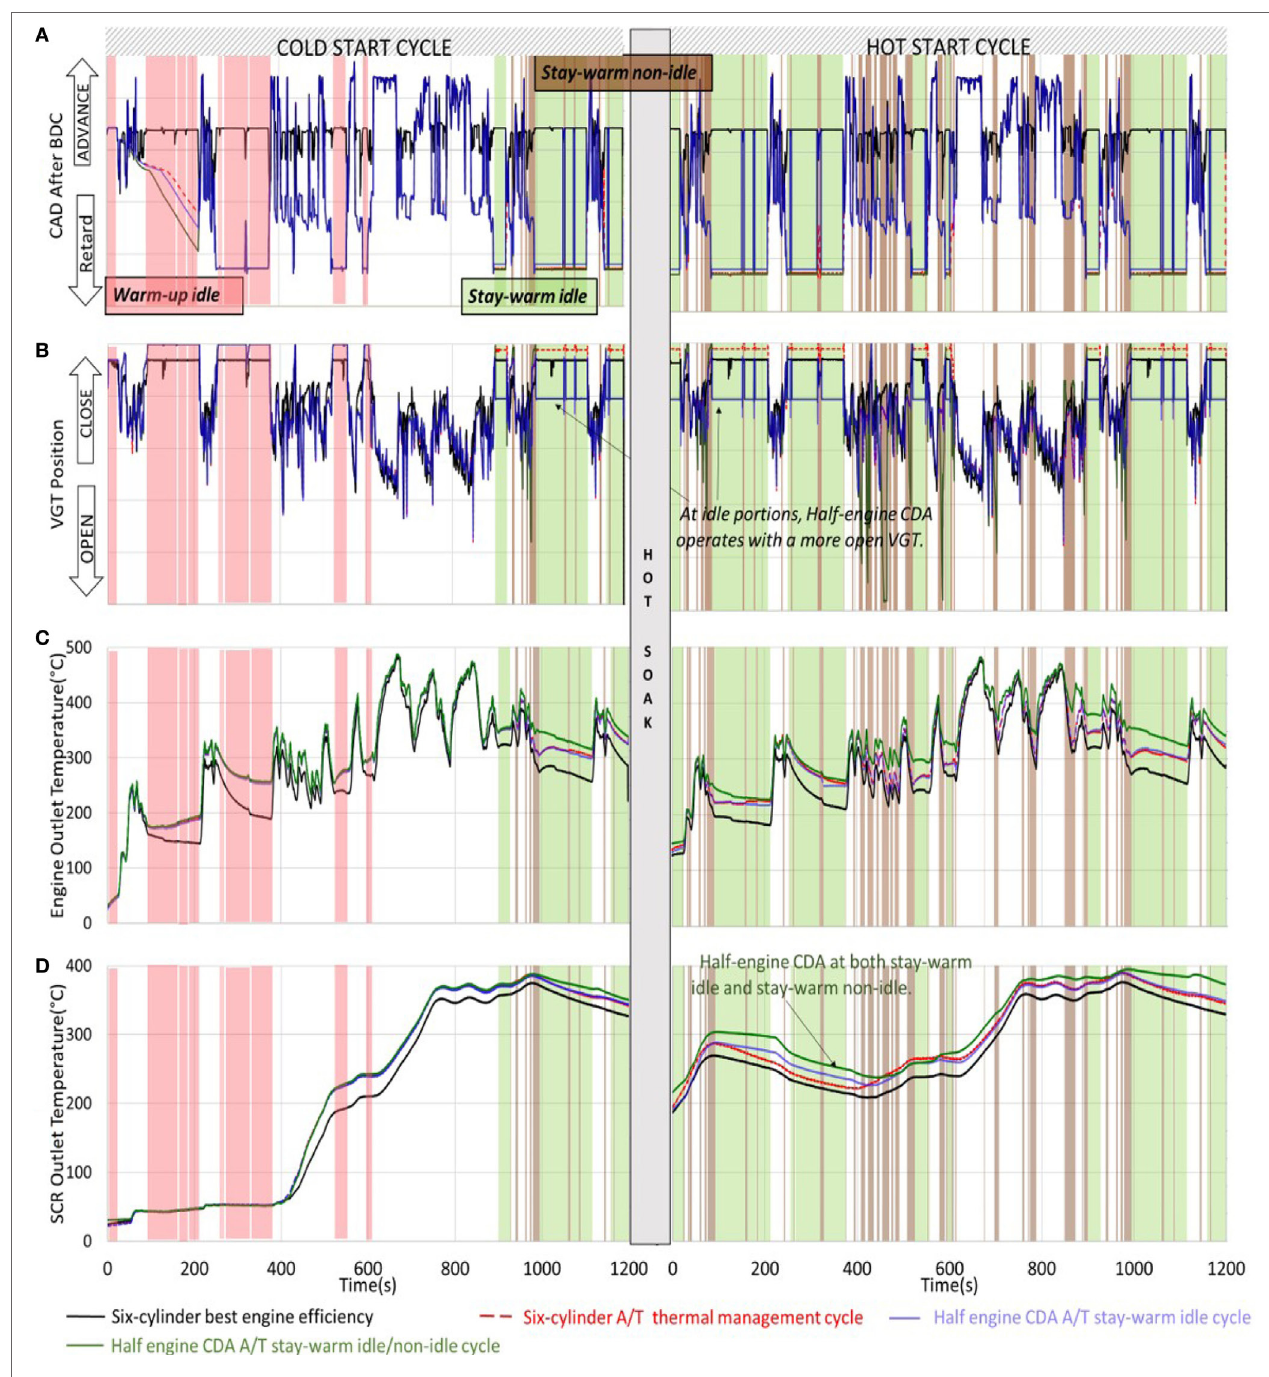
FigUre 16 | (a) Fuel start of injection (SOI) implemented over the HD-FTP for each of the cycles. (B) VGT positions implemented over the HD-FTP for each of the cycles. (c,D) The “Six-cylinder A/T thermal management cycle” and “Half-engine CDA A/T stay-warm idle cycle” strategies result in engine-outlet gas temperatures (c) , and SCR outlet temperatures (D) , that are comparable to each other, and superior to those for the “Six-cylinder best engine efficiency cycle.” “Half-engine CDA stay-warm idle/non-idle cycle” results in higher EOT and SCR outlet temperature than the other three